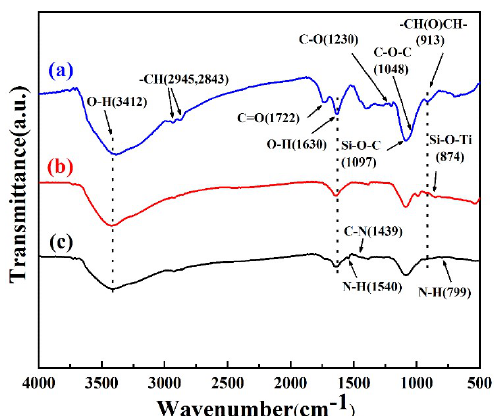
Figure 2. Fourier transform infrared spectroscopy (FTIR) spectra of ( a ) functionalized graphene oxide (f-GO), ( b ) functionalized Nano-Ti particles (f-Ti), and ( c ) GO-Ti composites.